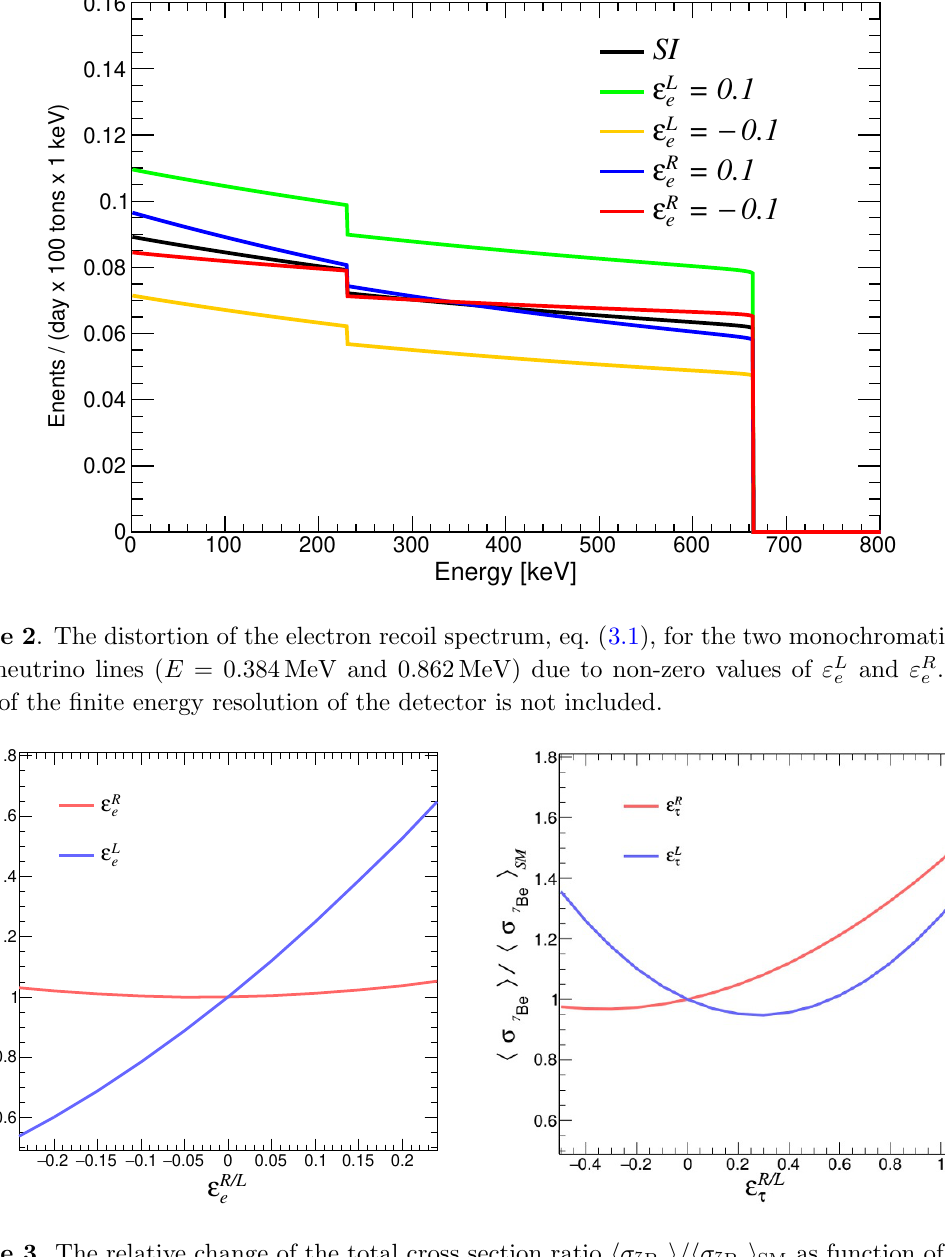
i = h (cid:27) 7 i SM as function of " R=L e Be Be